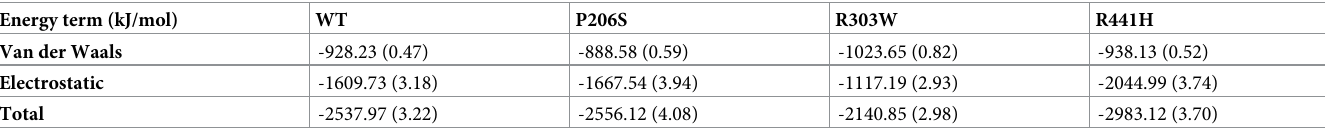
Fig 12. Hydrophobic contact analysis of TPH2 WT and its variants. The number of hydrophobic contacts formed during the simulations of TPH2 WT and its variants is shown as a function of time. (A) Comparison between the WT (black) and P206S variant (dark yellow). (B) Comparison between the WT (black) and R303W variants (purple). (C) Comparison between the WT (black) and R441H variant (turquoise).